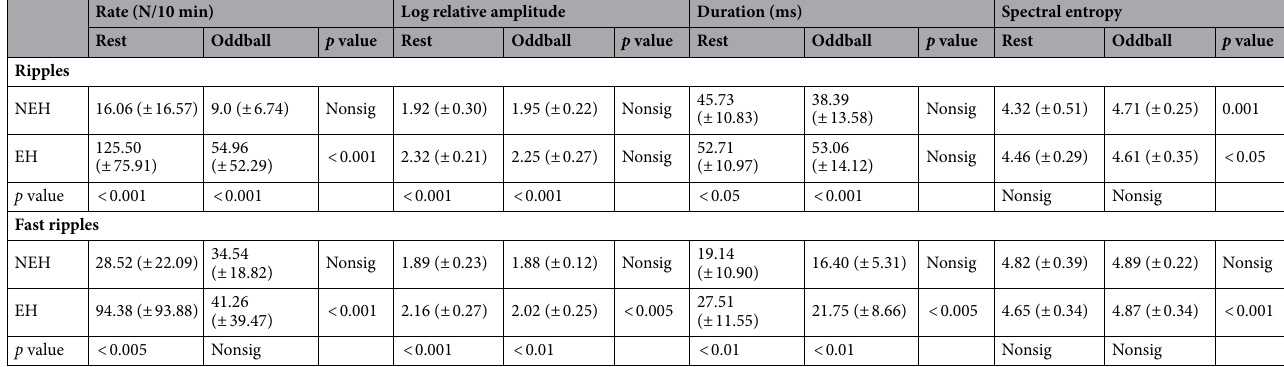
Table 3. HFO characteristics per contact in the ripple and fast ripple ranges during rest and the oddball task.